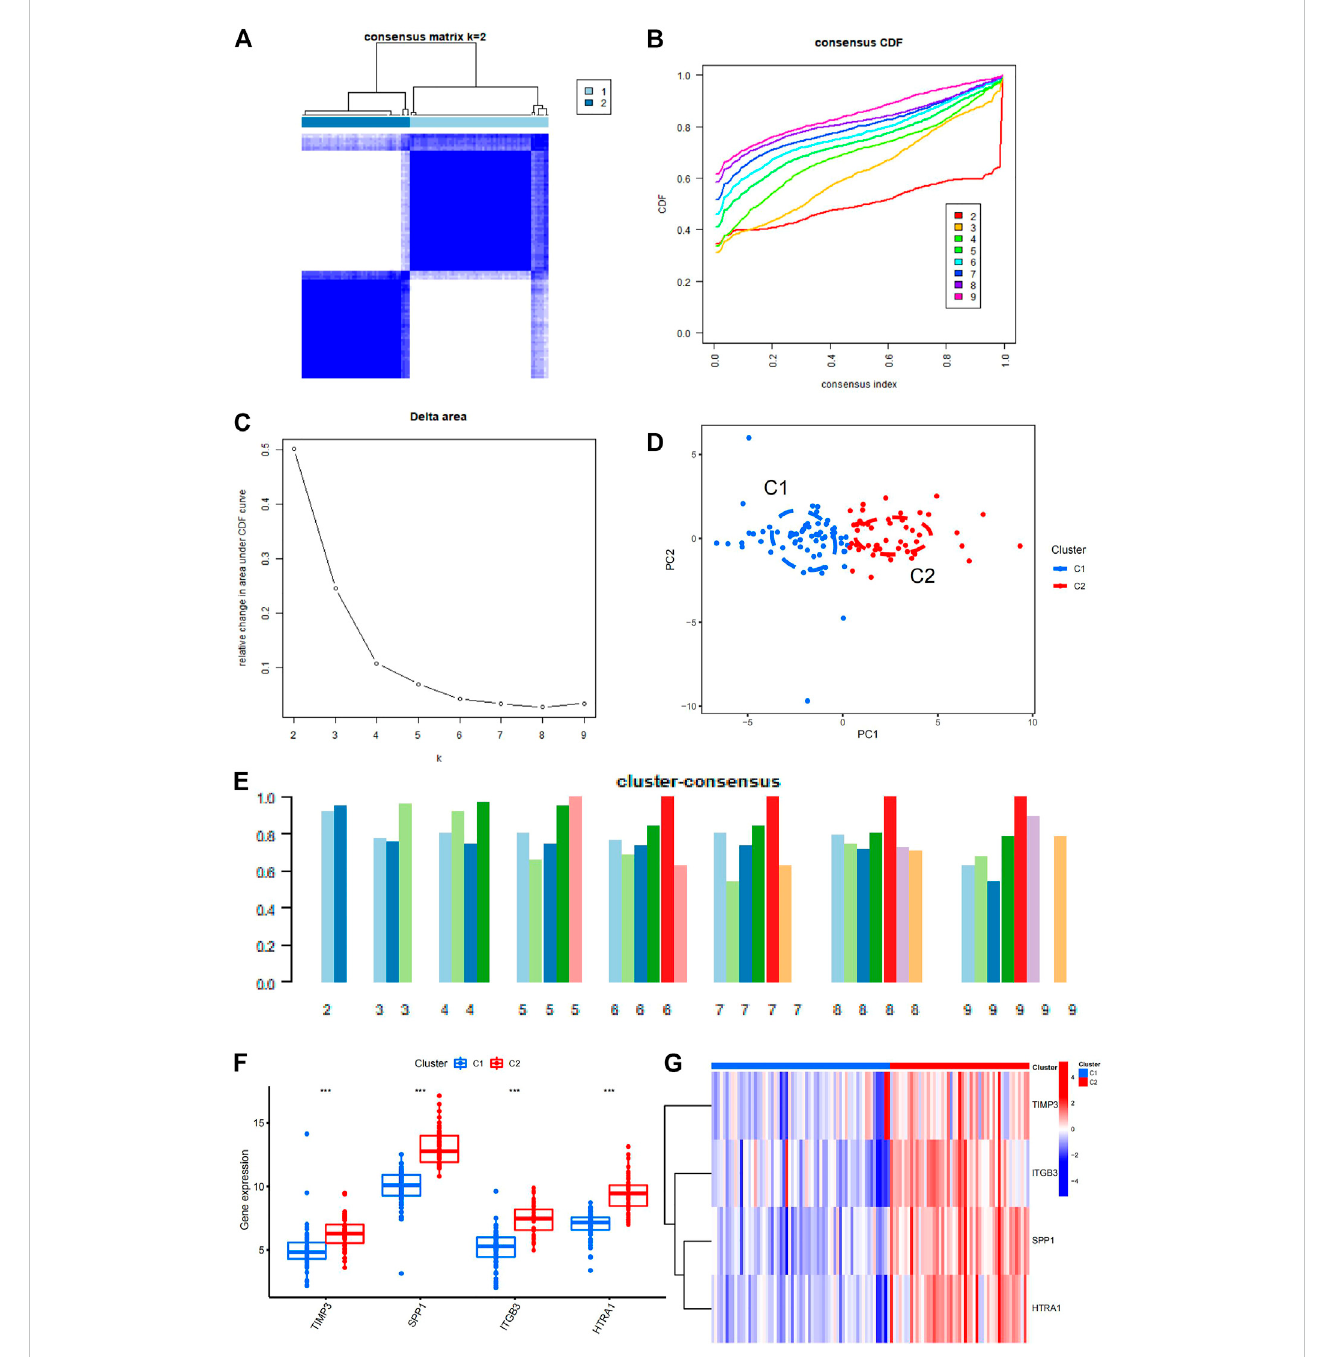
FIGURE 4 Consensus clustering of IPF samples. (A) Consensus clustering matrix constructed based on the fi nal K = 2. (B) Consensus CDF. The different color numbersinthe fi gurerepresentthedifferentKfromtwotonine.Thehorizontalcoordinaterepresentsconsensusindexandtheverticalcoordinaterepresents CDFvalue. (C) AreaundertheCDF.ThehorizontalcoordinaterepresentsthedifferentKfromtwotonineandthevertical coordinaterepresentsthechangein area under the CDF curve. (D) PCA of the two clusters. C1 is cluster 1, C2 is cluster 2. (E) The cluster-consensus plot demonstrates the consensus clustering results. The horizontal coordinate represents the different K from two to nine and the vertical coordinate represents the consistency score. (F) The box plot shows the signi fi cant differences in the four EMT-related genes between the two clusters. C1 is cluster 1, C2 is cluster 2. (G) The heatmap shows the speci fi c differences in the four genes between the two clusters. C1 is cluster 1, C2 is cluster 2. IPF, idiopathic pulmonary fi brosis; CDF, cumulative distribution function; PCA, principal component analysis; EMT, epithelial – mesenchymal